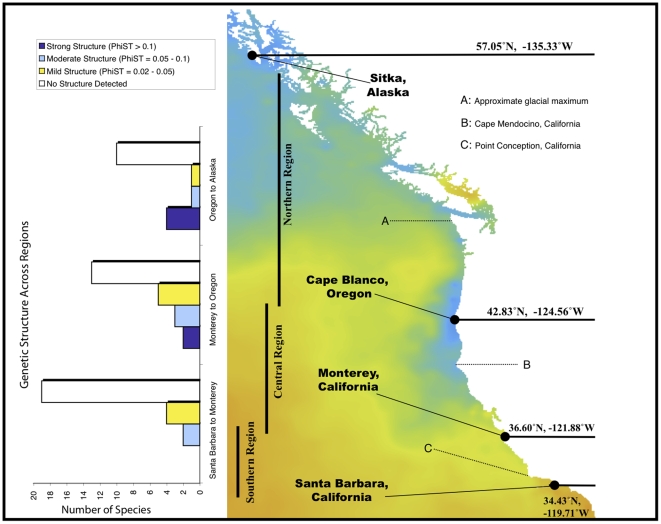
Map of primary collection locations, geographic regions, and major ecological features of the Pacific coast of North America.The background color represents sea surface temperature for a day in July, 2008. Bar graphs on the left-hand side of the figure show the number of species with strong, moderate and mild genetic structure in southern, central and northern comparisons. Structure categories are mild: ΦST = 0.02 – 0.05, moderate: 0.05 – 0.10, strong:>0.1.